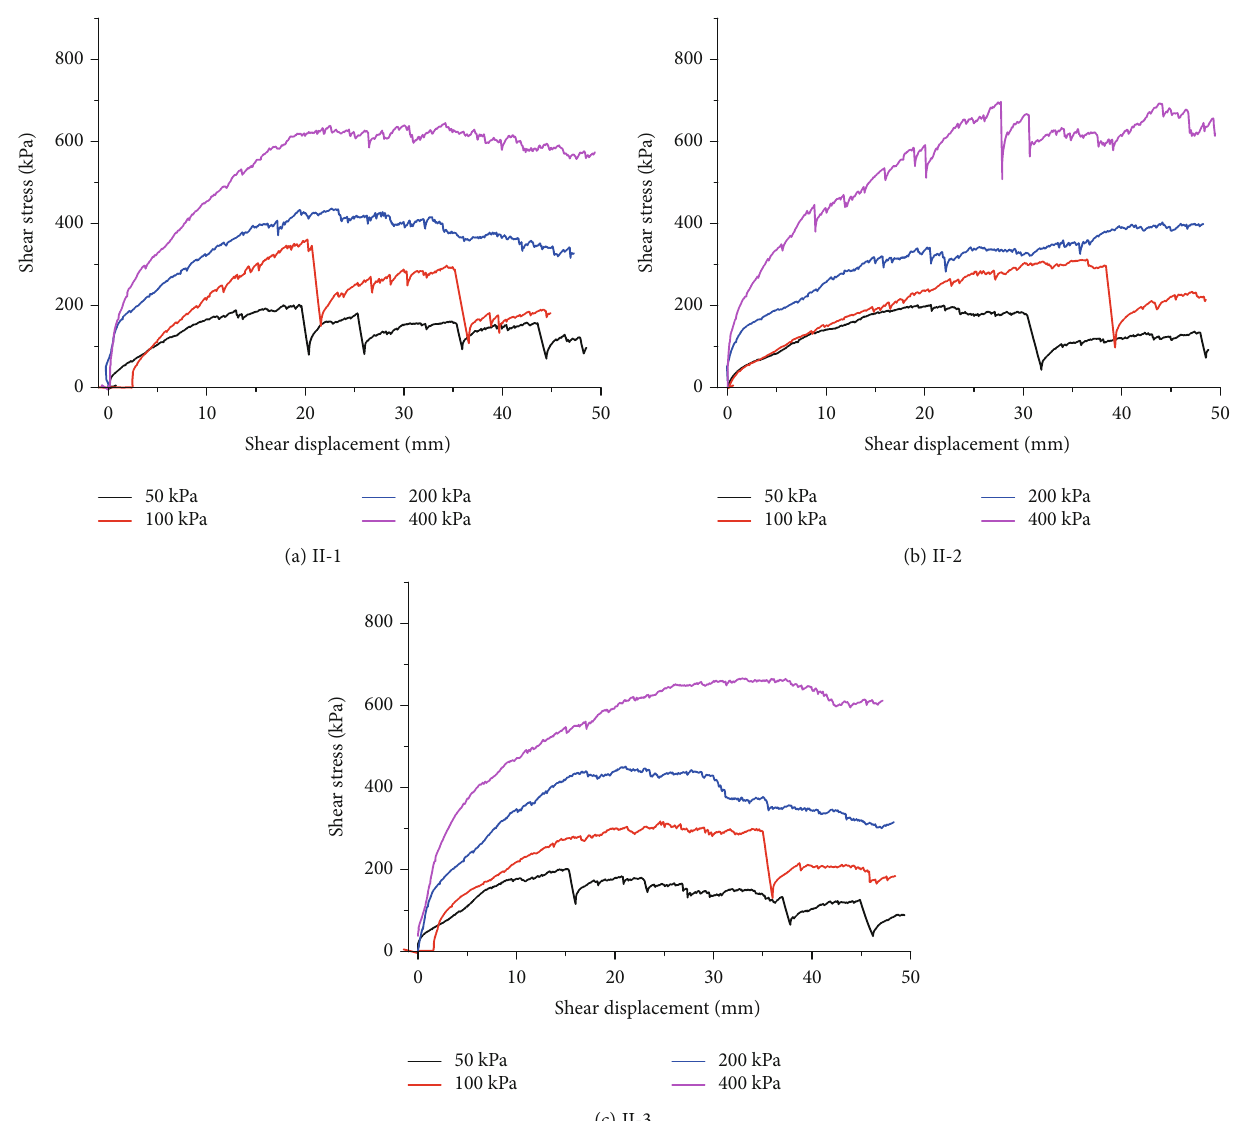
Figure 3: Shear stress versus shear displacement curves of group II (intermediate particle